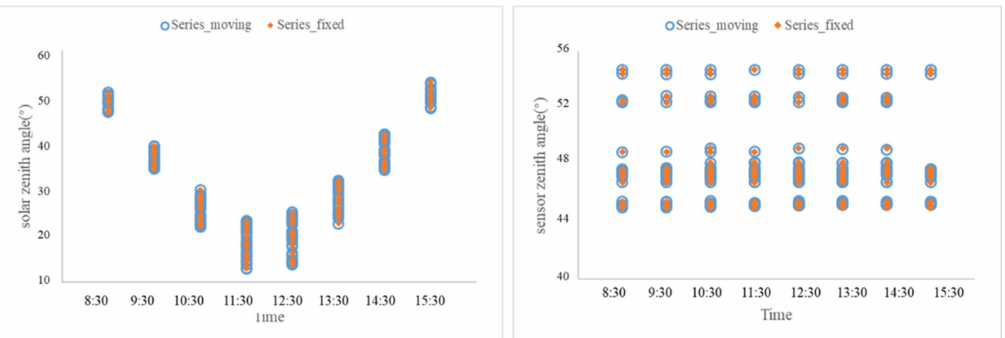
Figure 9. Solar zenith angle ( a ) and sensor zenith angle ( b ) for the GOCI mission. Only data that passed the exclusion criteria are used. The data are separated by the time of the